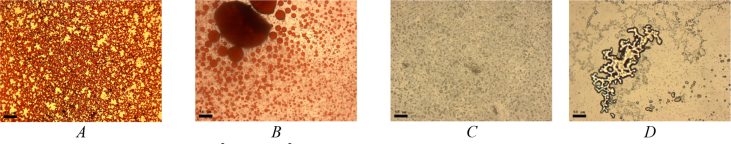
Application of Mg2+ and Fe2+ mixture (1–1 ratio, c = 4 mM) in clusterization process for TX-100 (A) and TX-114 (B); Effect of Fe2+ addition to freshly-prepared Ni2+-based micellar clusters, before iron salt addition (C) and after (D). Scale bar is 50 μm.